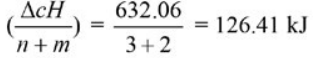
Table 2. The correlation dependence between the average atomic enthalpy of combustion Δ sicity constants in acidic aqueous solutions of pK Amide